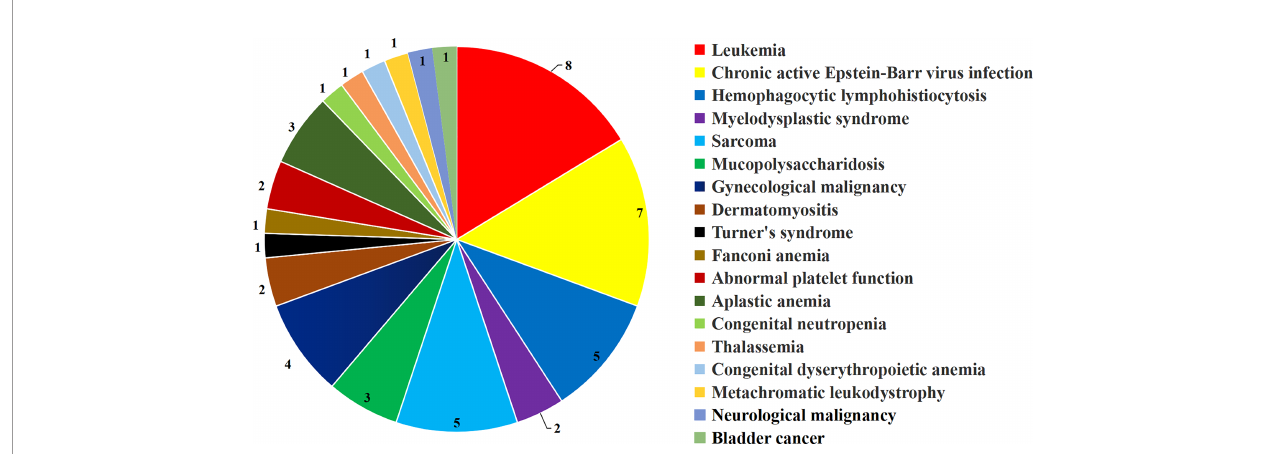
FIGURE 2 | Disease classi fi cation of 49 children undergone OTC. OTC, ovarian tissue